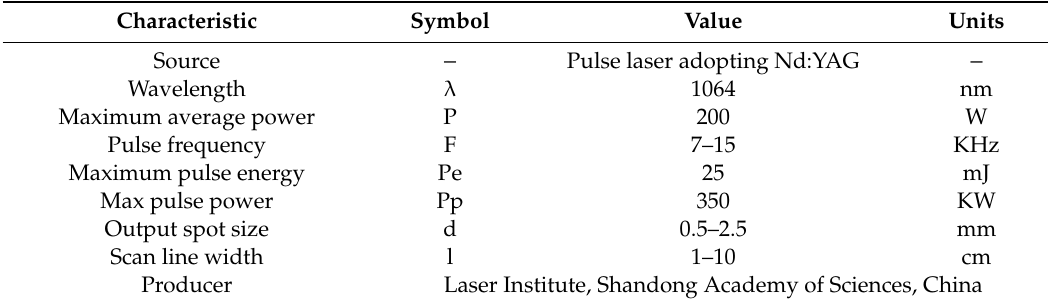
Table 2. Main parameters of the